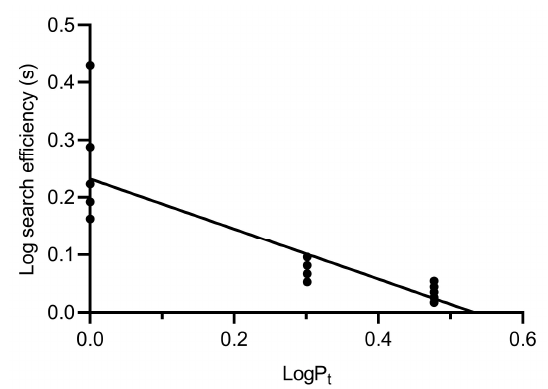
Figure 5. Density interference of Psyllaephagus sp. females.